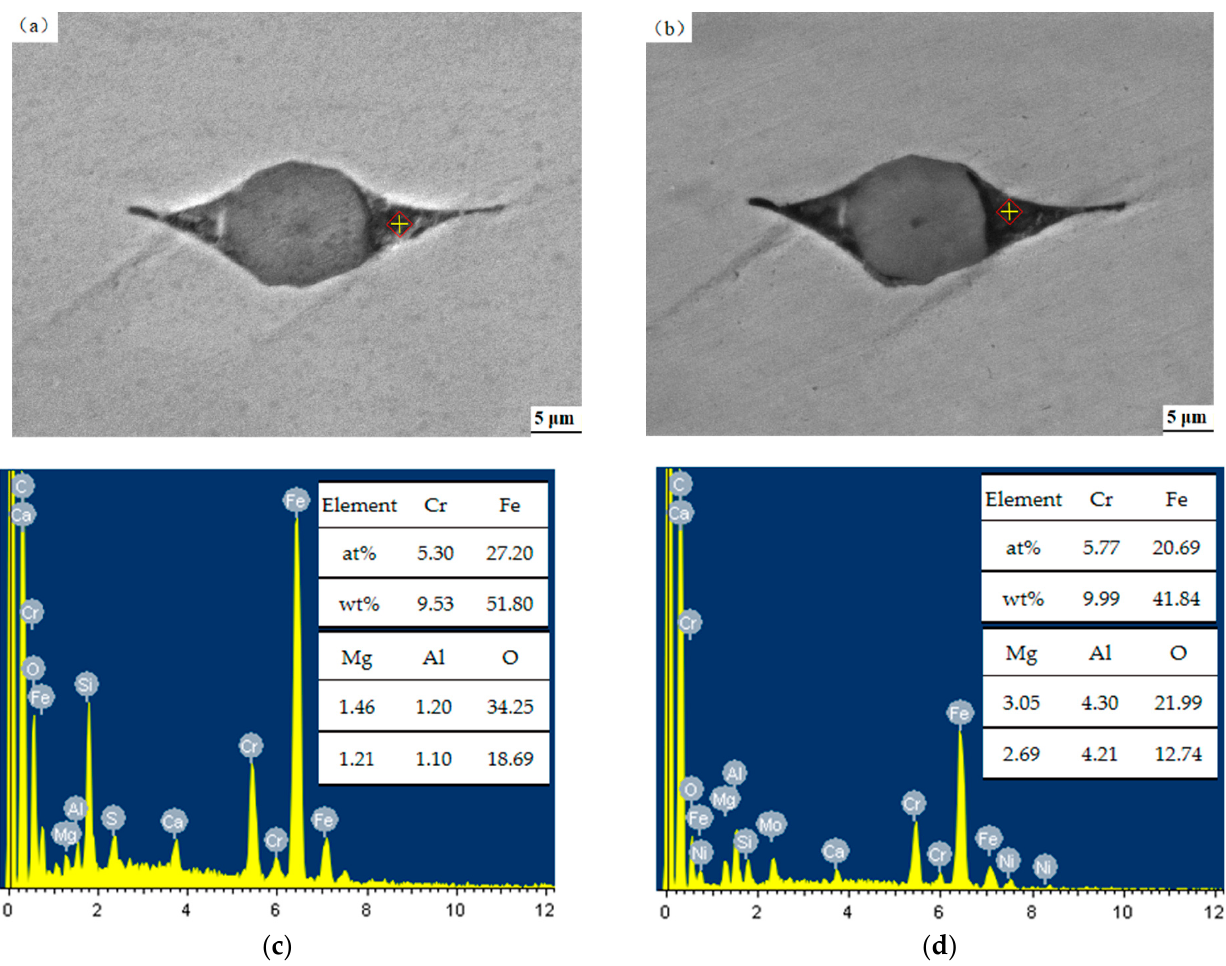
Figure 4. The morphologies of one defect with and without acidification and the corresponding EDS spectra. ( a , c ) before soaking; ( b , d ) after soaking with dwell time of 30 s.